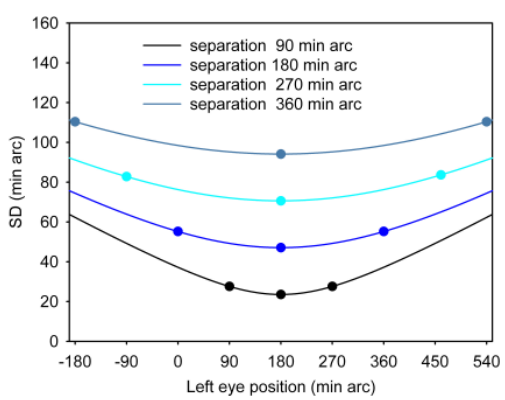
Figure 3: Typical, simulated hyperbola curves for the SD for a variable separation between 3 calibration points.